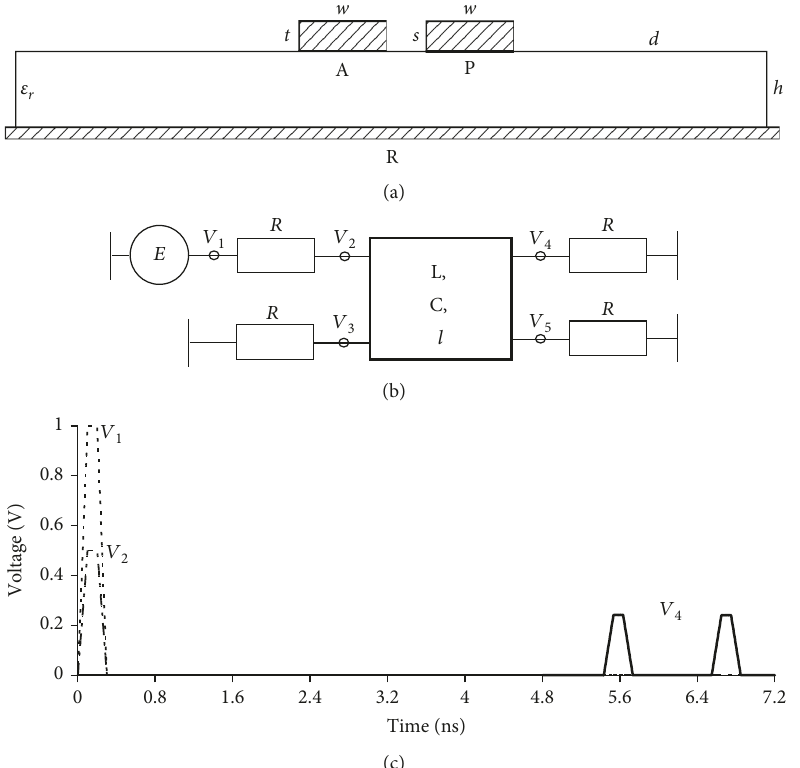
Figure 1: (a) Cross-section of the MF based on the coupled line, (b) its equivalent circuit, and (c) waveforms ( V ( V 2 ) at the input and ( V 4 ) output of such an MF.